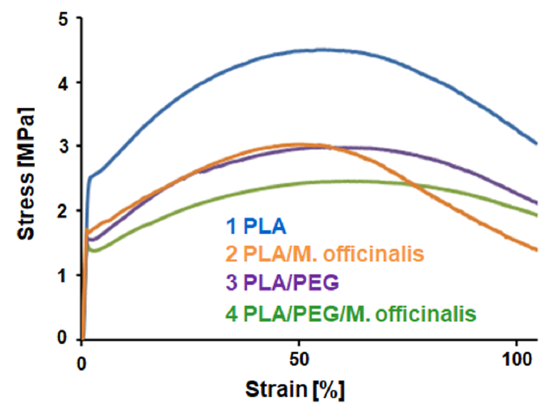
Figure 6. Stress–strain curves of fibrous PLA, PLA/ M. officinalis (10 wt%), PLA/PEG and Stress–strain curves of fibrous PLA, PLA/ M. officinalis (10 wt%), PLA/PEG and PLA/PEG/ M. officinalis (10 wt%)mats obtained by electrospinning. PLA/PEG/ M. officinalis (10 wt%) mats obtained by